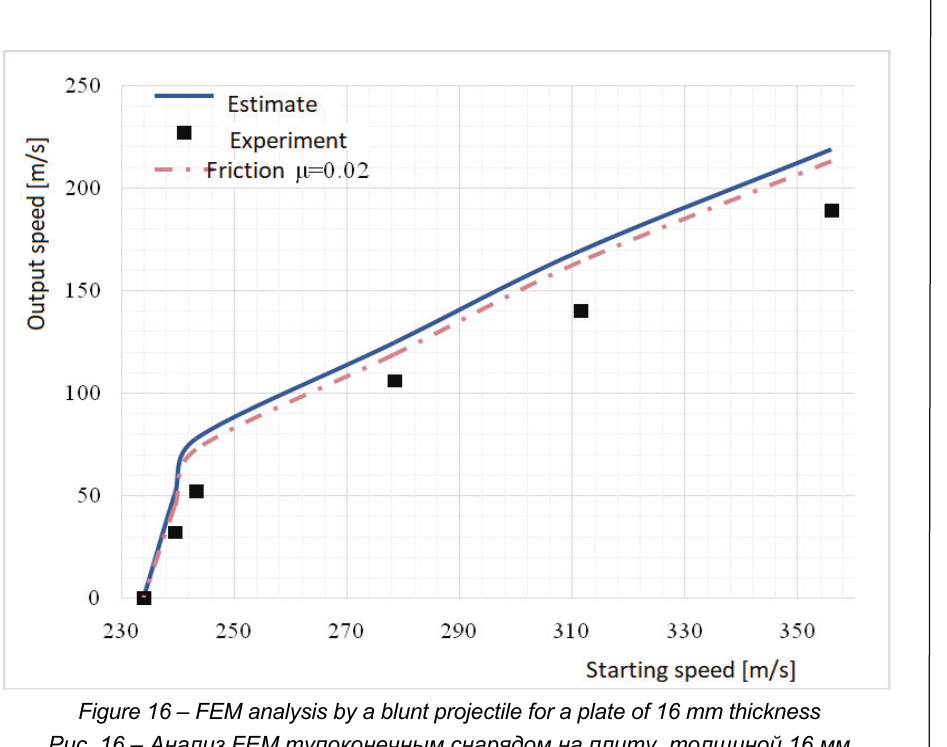
Figure 16 – FEM analysis by a blunt projectile for a plate of 16 mm thickness